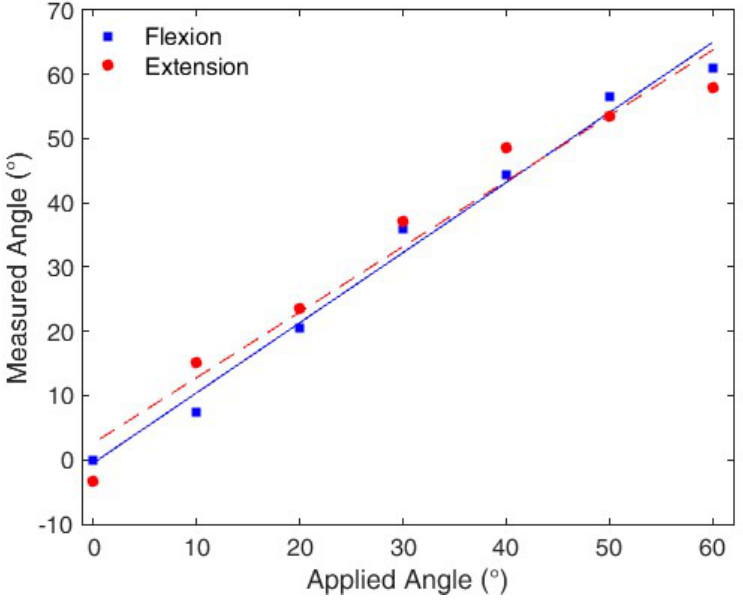
Figure 9. Measured angles for flexion and extension cycles after applying the compensation technique.